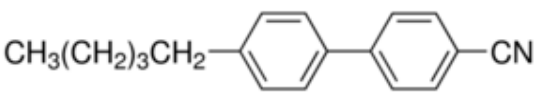
(cid:48) -Pentyl-4-biphenylcarbonitrile is representative of the liquid crystal Figure 6. 4 ′ -Pentyl-4-biphenylcarbonitrile is representative of the liquid crystal mixture. Figure 6. 4